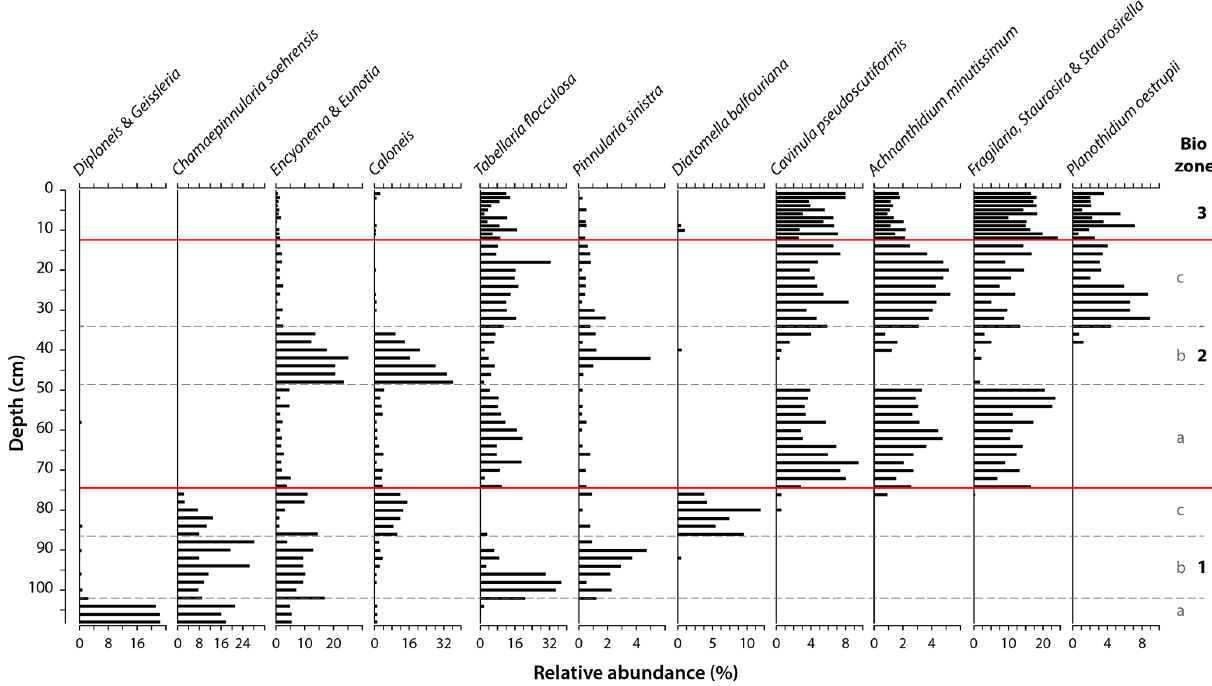
Figure 5. Biostratigraphy (fossil diatoms) of a sediment core collected in Gull Lake in June 2015. Data are displayed as relative abundance (%) of dominant taxa, i.e., representing more than 5% in at least one level. The relative abundance scale varies by taxa. Complete data (Pienitz et al., 2019) are available in open-access files (see “Data availability” section). Plates (photographs) of the most abundant species are shown in Supplement